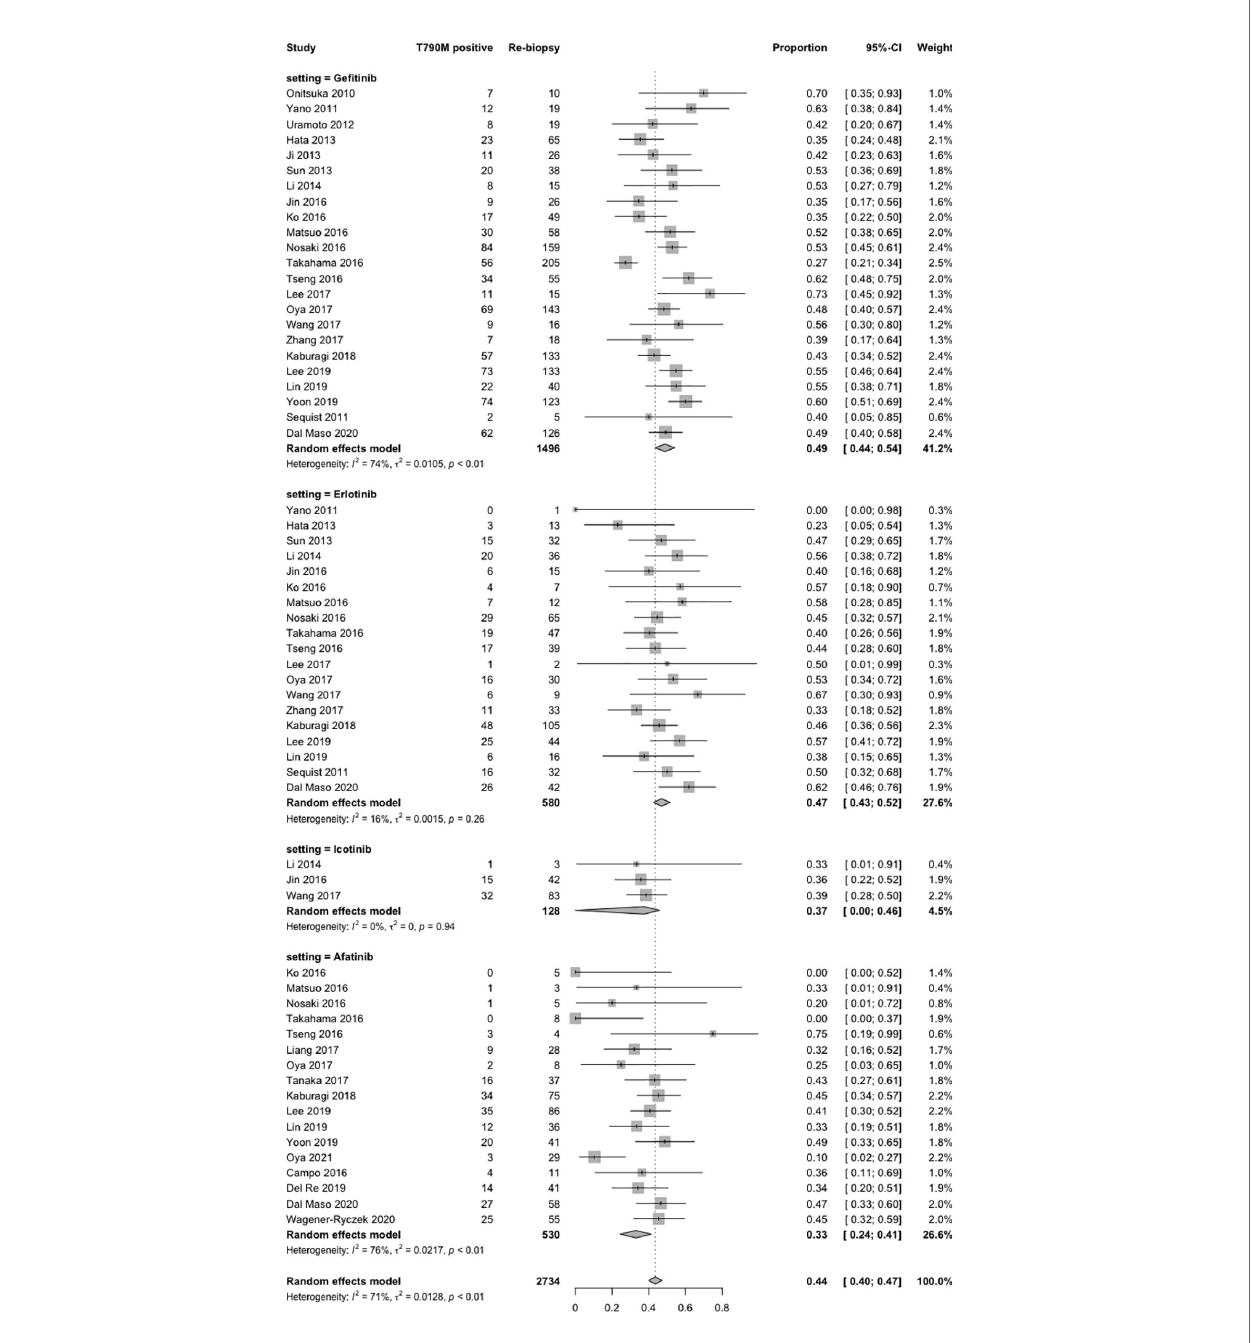
FIGURE 3 | Forest plot of subgroup single-arm meta-analysis of all